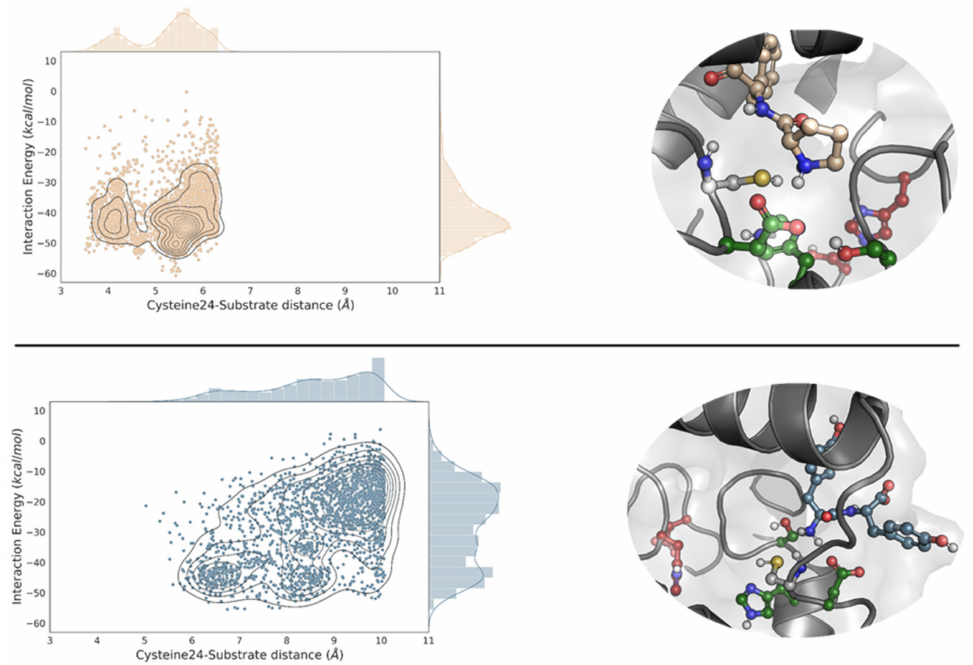
Figure 2. PELE’s energy analysis and representative geometries. EH 1AB1C density plots of the distribution of the catalytic cysteine-substrate distances against the interaction energy for the best- bound dipeptide substrate (PF, top) and the worst one (YY, bottom). Only the 10% lowest percentile, regarding the distance is shown. In the right panel, we display representative catalytic poses of the dipeptide substrate in the putative protease site. The C atoms are stained in maroon, dark green and yellow in the EH 1A1 active site residues, EH 1B1 and Cys24, respectively, and each substrate is shown using the density plot colour (in wheat for PF and blue for YY). The energy profiles were created with the Matplotlib library